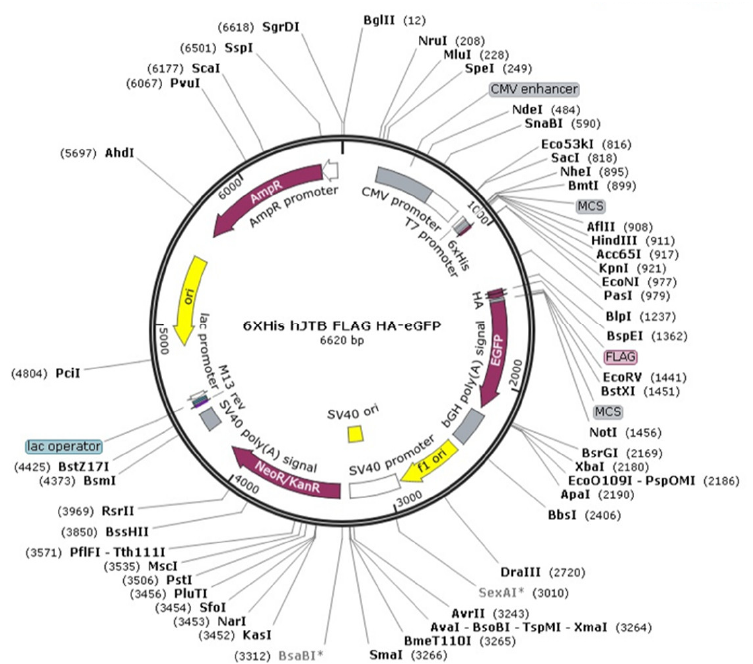
Figure 1. Plasmid for upregulation from Creative Biogene with customized 6X His tag at the N- terminus, HA, FLAG and eGFP tag at the C-terminus.